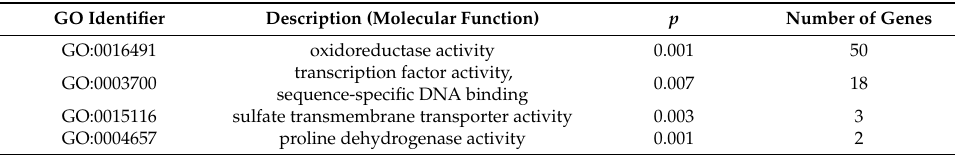
Table 3. Gene ontology (GO) categories statistically over-represented for genes coexpressed with salt-responsive PvbZIP38 and